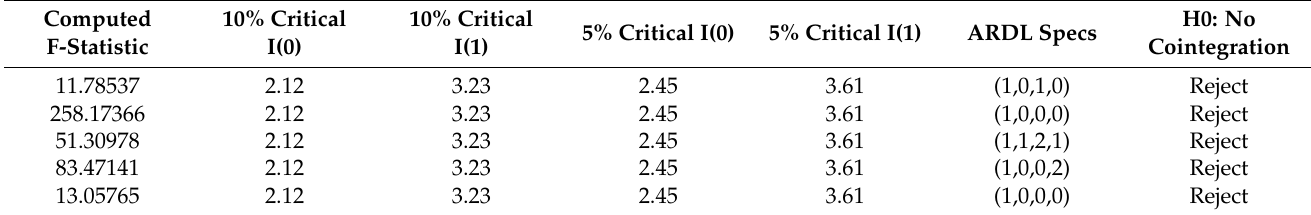
Table A4. The results of the bounds test for cointegration for CMA.